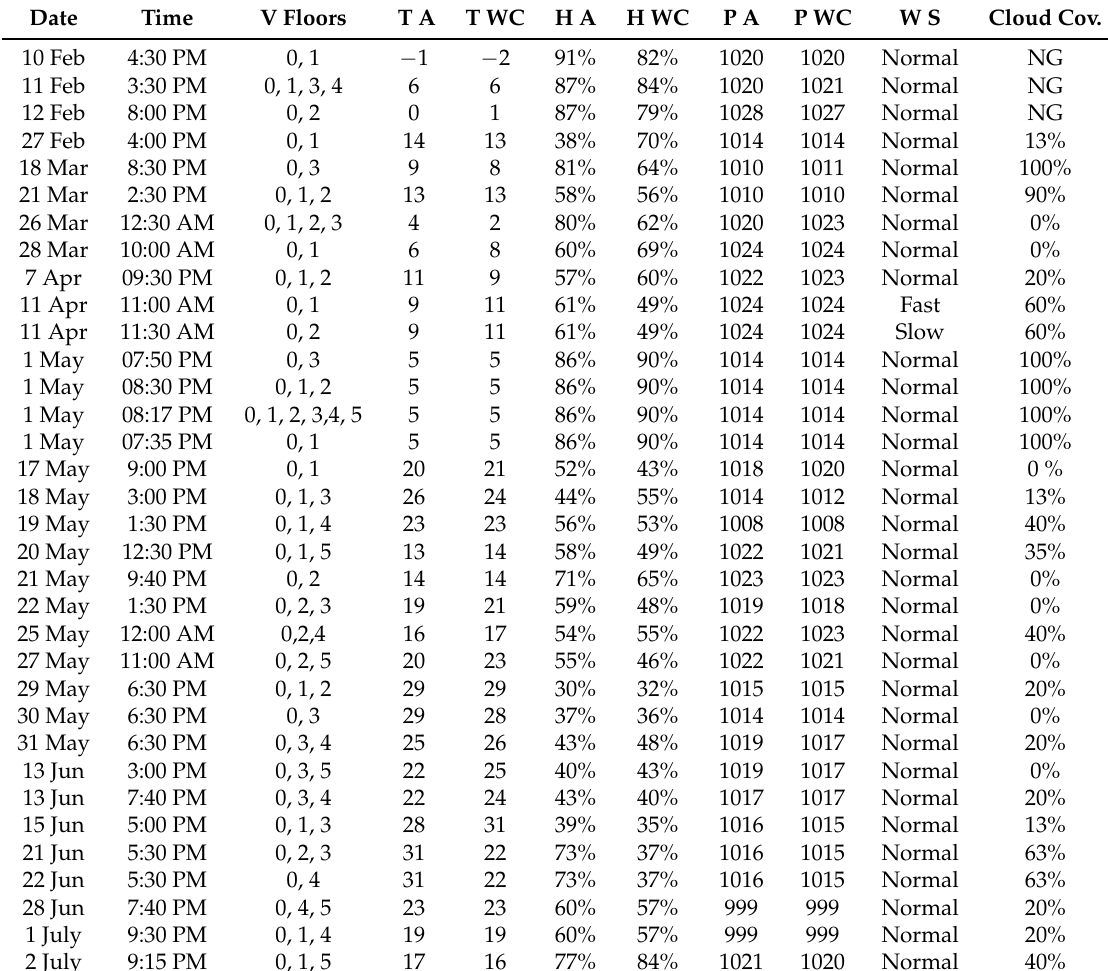
Table A1. Collected data from TUM main campus. The table shows the data acquisition date, the time, the visited floors (V Floors), the indicated temperature from AccuWeather (T A) and Google (T A) (unit: ◦ C), the relative humidity from the same two sources (H A) and (H G), and the ambient pressure from AccuWeather (P A) (unit: Pa).